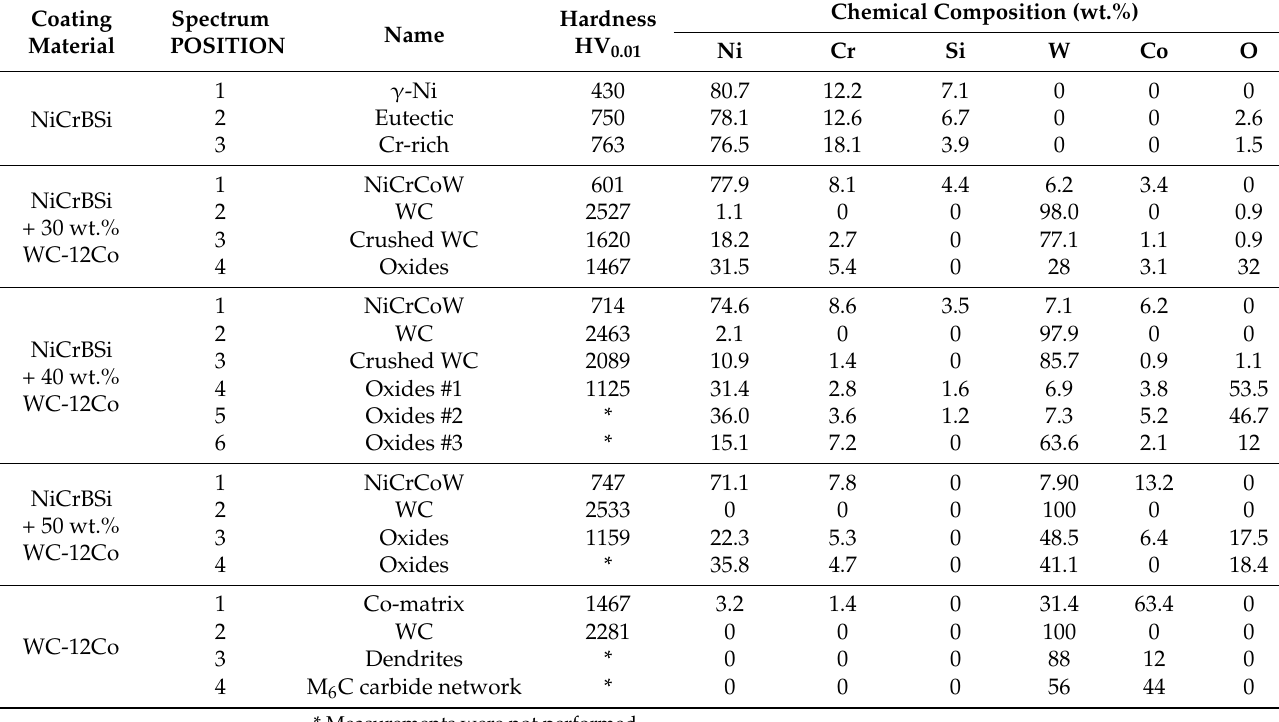
Table 4. Chemical composition (EDS) and Vickers microhardness of NiCrBSi + 30, 40, 50 wt.% WC-12Co claddings at different points.